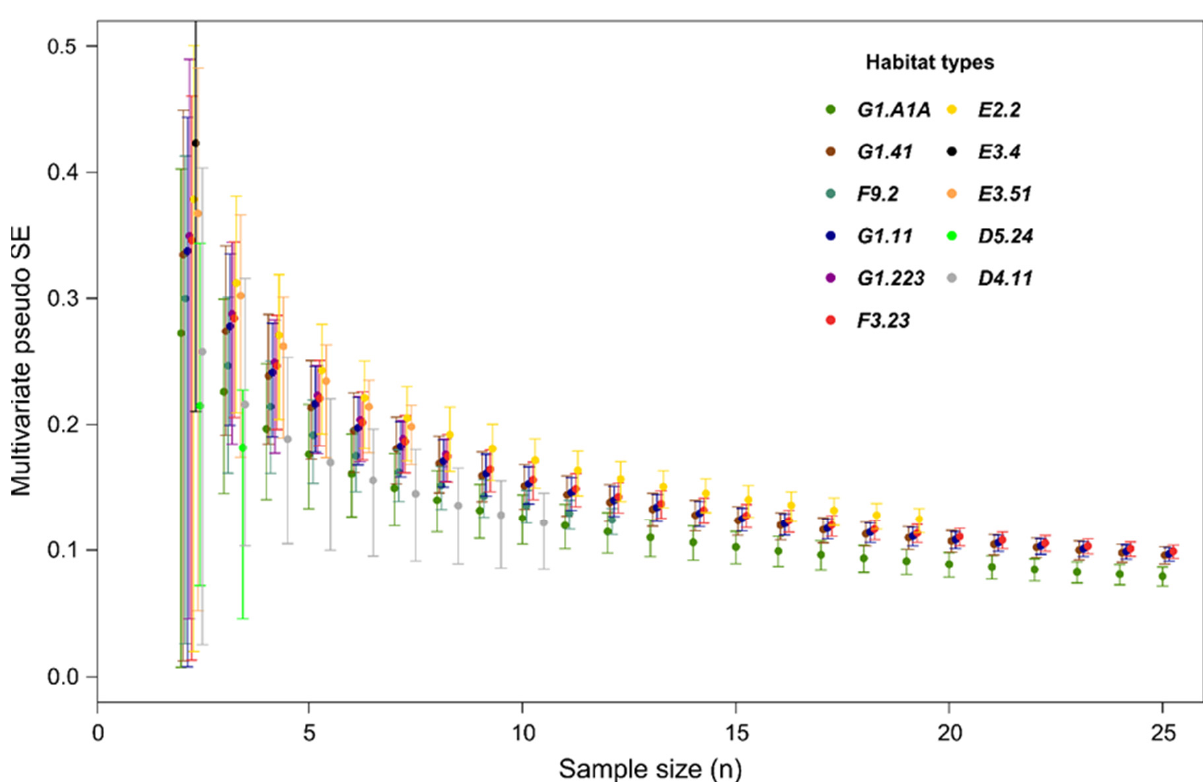
Figure 4. MultSE profile based on Bray–Curtis dissimilarity for each habitat within the ecological network. The white space on the left is due to a MultSE higher than 0.5 in the first plots. Based on habitats’ MultSE profiles, the minimum number of replicates needed to characterize the main features of each habitat was reported in Table S1, while the minimum number of replicates needed for the whole EN was 27.77 ± 1.77 (mean ± SD) according to the point where the slope of MultSE profile